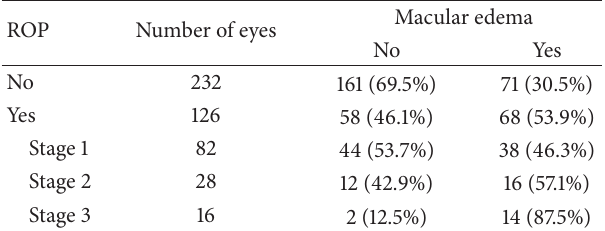
ROP: retinopathy of prematurity.